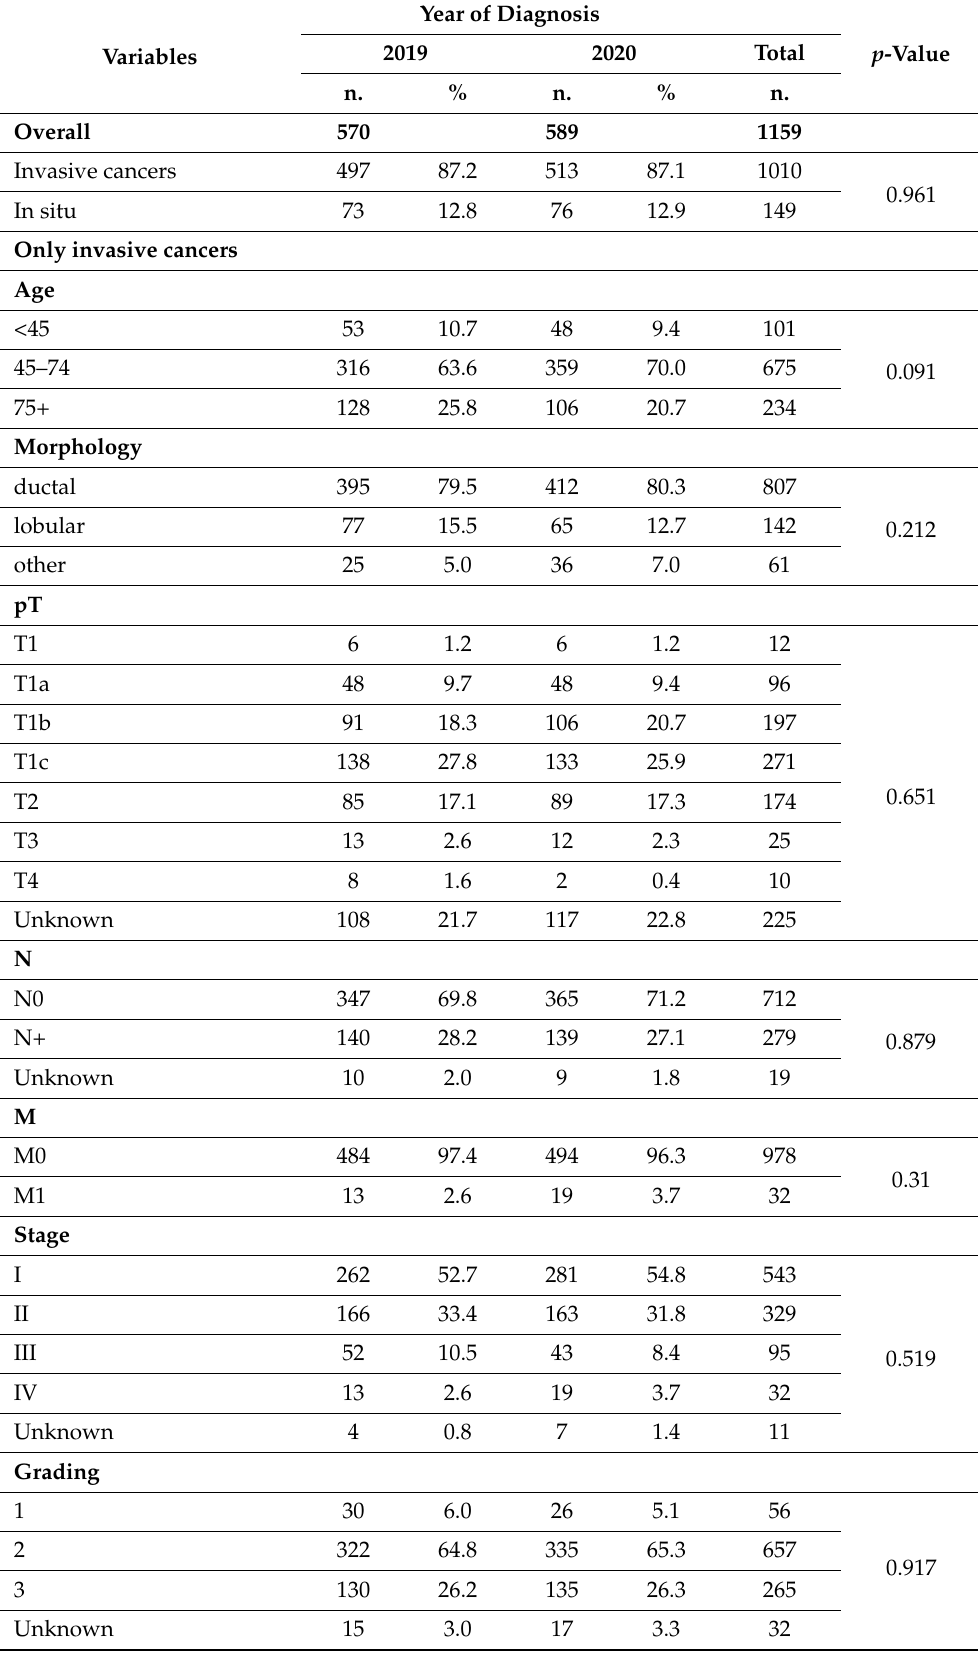
Table 1. Characteristics of women with breast cancer, by year of diagnosis.